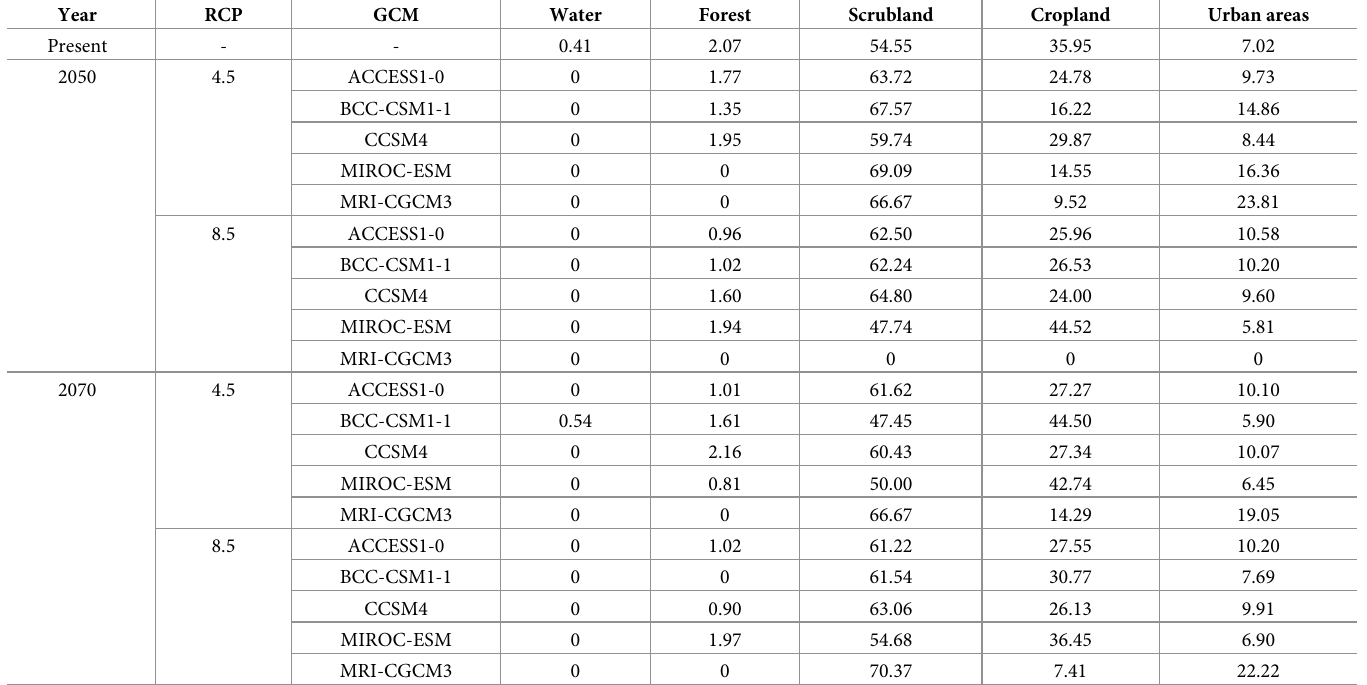
Table 3. Percentage of each land use category within the predicted area of occurrence according to each